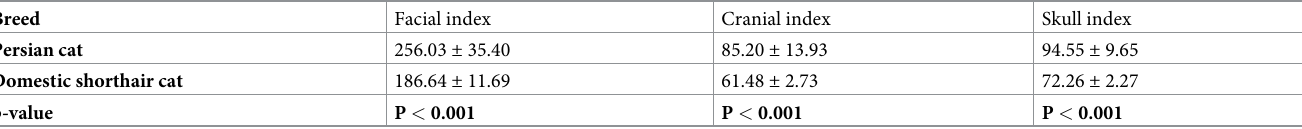
Table 1. Summary of the comparison of the craniometric indices between the Persian and Domestic shorthair cats.